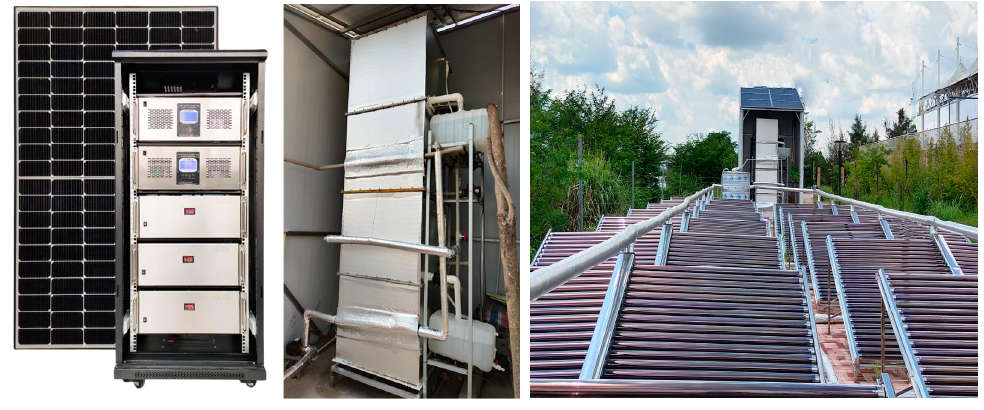
Figure 22. Part of the experimental devices.